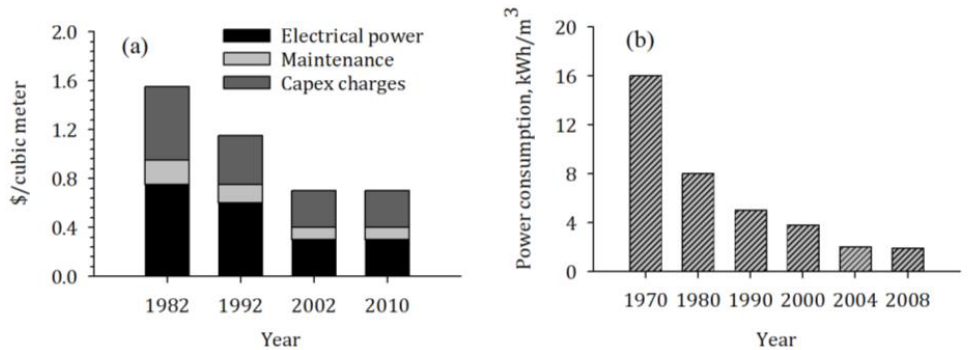
Figure 5. Trends of ( a ) cost in USD/m 3 [9] and ( b ) power consumption in kWh/m 3 [10] in seawater reverse osmosis plants.